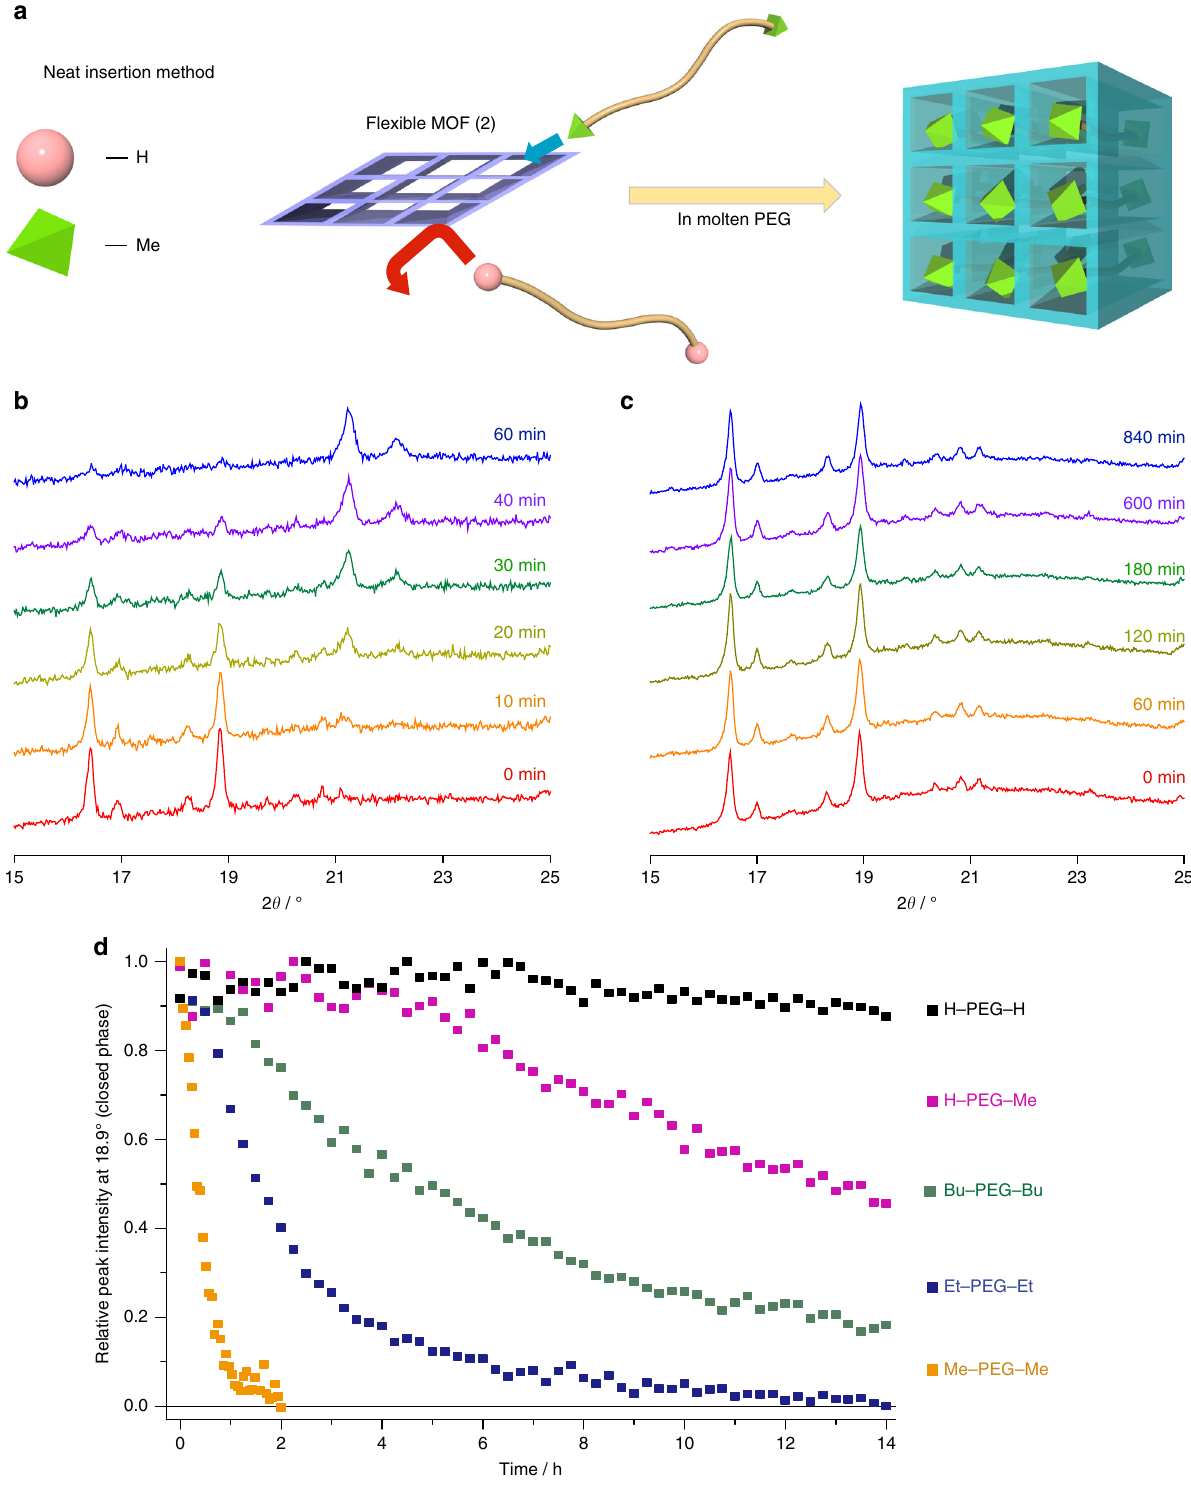
Fig. 3 Introduction of PEG into 2 using neat insertion method. a Schematic for sorting polymers with different terminal groups of similar sizes using a fl exible MOF system (neat insertion method). b , c Time-resolved in situ PXRD patterns of 2 in presence of Me – PEG – Me and H – PEG – H, respectively. d Evolution of the proportion of closed-phase 2 (determined by following the intensity of the characteristic peak at 18.9°) in contact with several PEGs at 45 °C. M n of PEG used in these experiments was 1